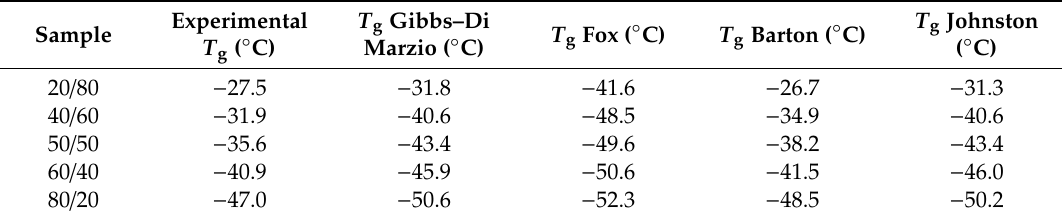
Table 4. Glass transition temperatures of the homopolymers and the statistical copolymers and predictions according to di ff erent